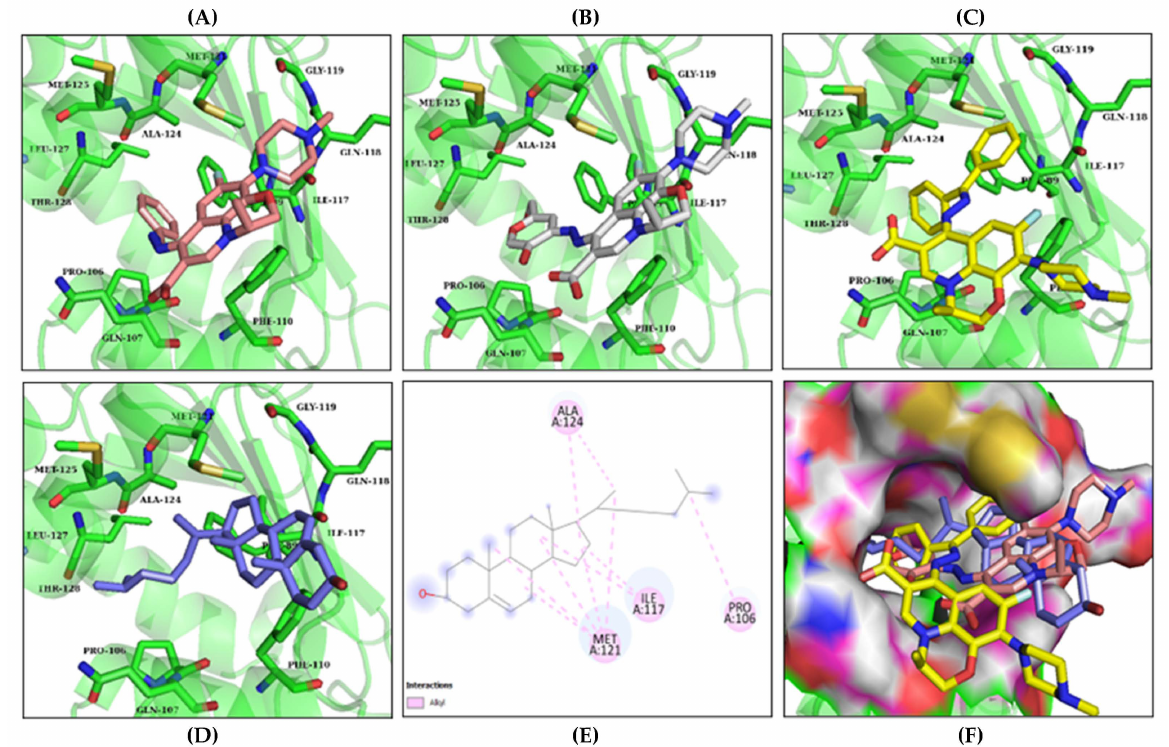
Figure 1. Predicted binding modes of OA-02, OA-06 and OA-09. ( A – D ) Sticks model representation of OA-02 (Brown), OA-06 (White), OA-09 (Yellow) and Cholesterol (Blue) binding with active site. ( E ) Interactions of Cholesterol with the binding pocket. ( F ) Representation of binding modes of selected compounds aligned on cholesterol in the binding pocket showing in